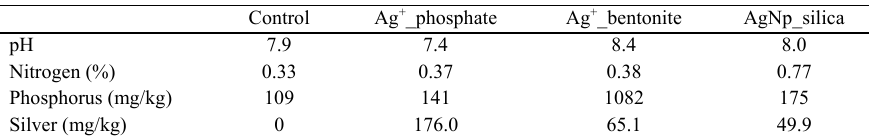
Table 2: Physicochemical characteristics of metal loaded soil